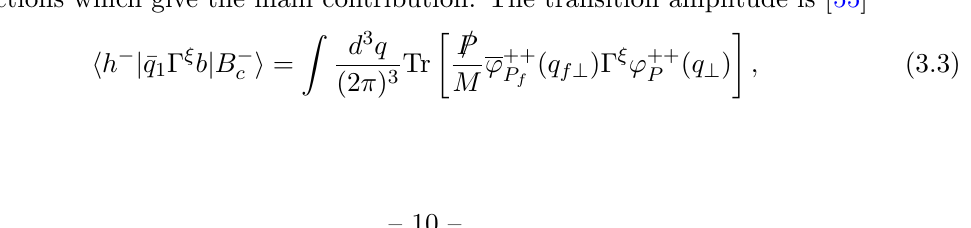
(cid:26) (cid:0) ( K (cid:3)(cid:0) ) (cid:31)(cid:31) !